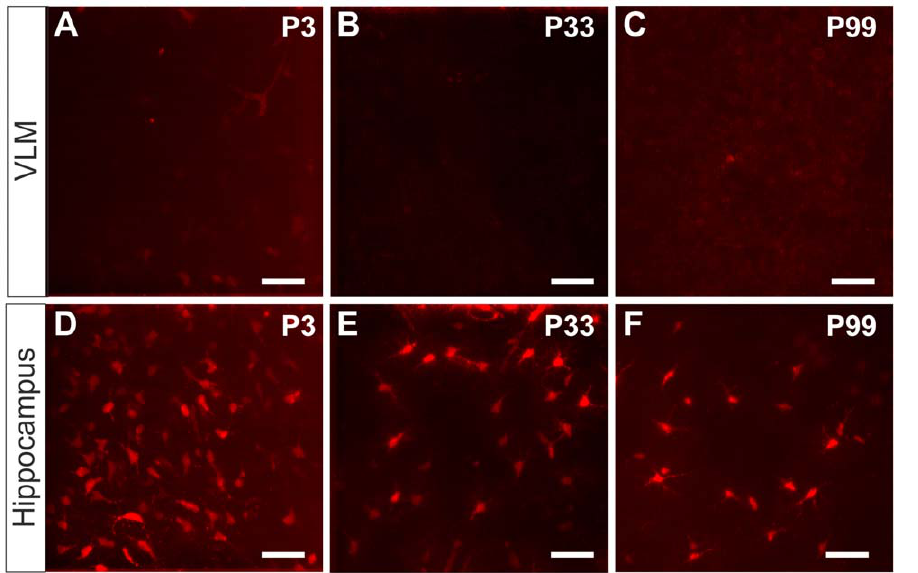
Figure 3. Comparison of SR101-staining in different ages. A–C: staining in the ventrolateral medulla (VLM) with 1 m M SR101 for 20 min and 10 min wash out. EGFP-fluorescence is not shown. The SR101 labeling was poor in all three tested ages. D–F: In the stratum radiatum of the hippocampal CA1 region SR101-labeling of juvenile (P33) an adult mice (P99) was very similar as compared to neonatal mice.